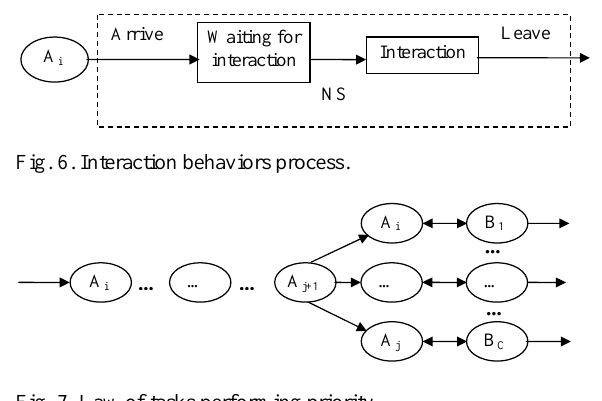
Fig. 7. Law of tasks performing